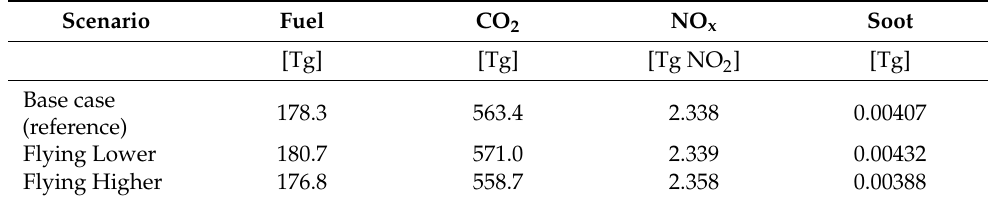
Table 1. Fuel consumption and emission of aviation in the reference case and the scenarios Flying Lower and Flying Higher